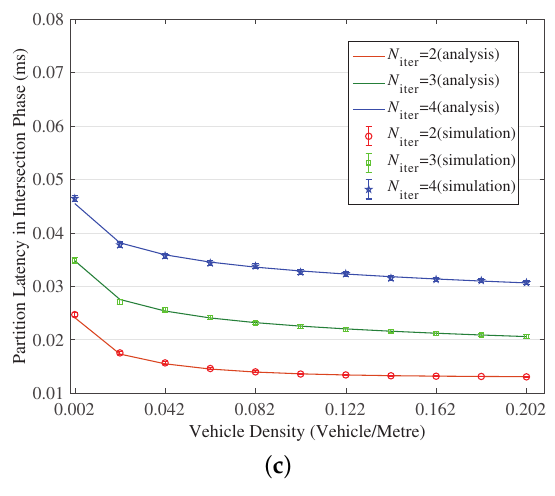
Figure 3. Validation of the model for partition latency in Intersection Phase. ( a ) When ( N iter , N part ) = (2, 3); ( b ) When ( N iter , A ) = ( 2,2 ) ; ( c ) When ( N part , A ) = ( 4,2 ) .